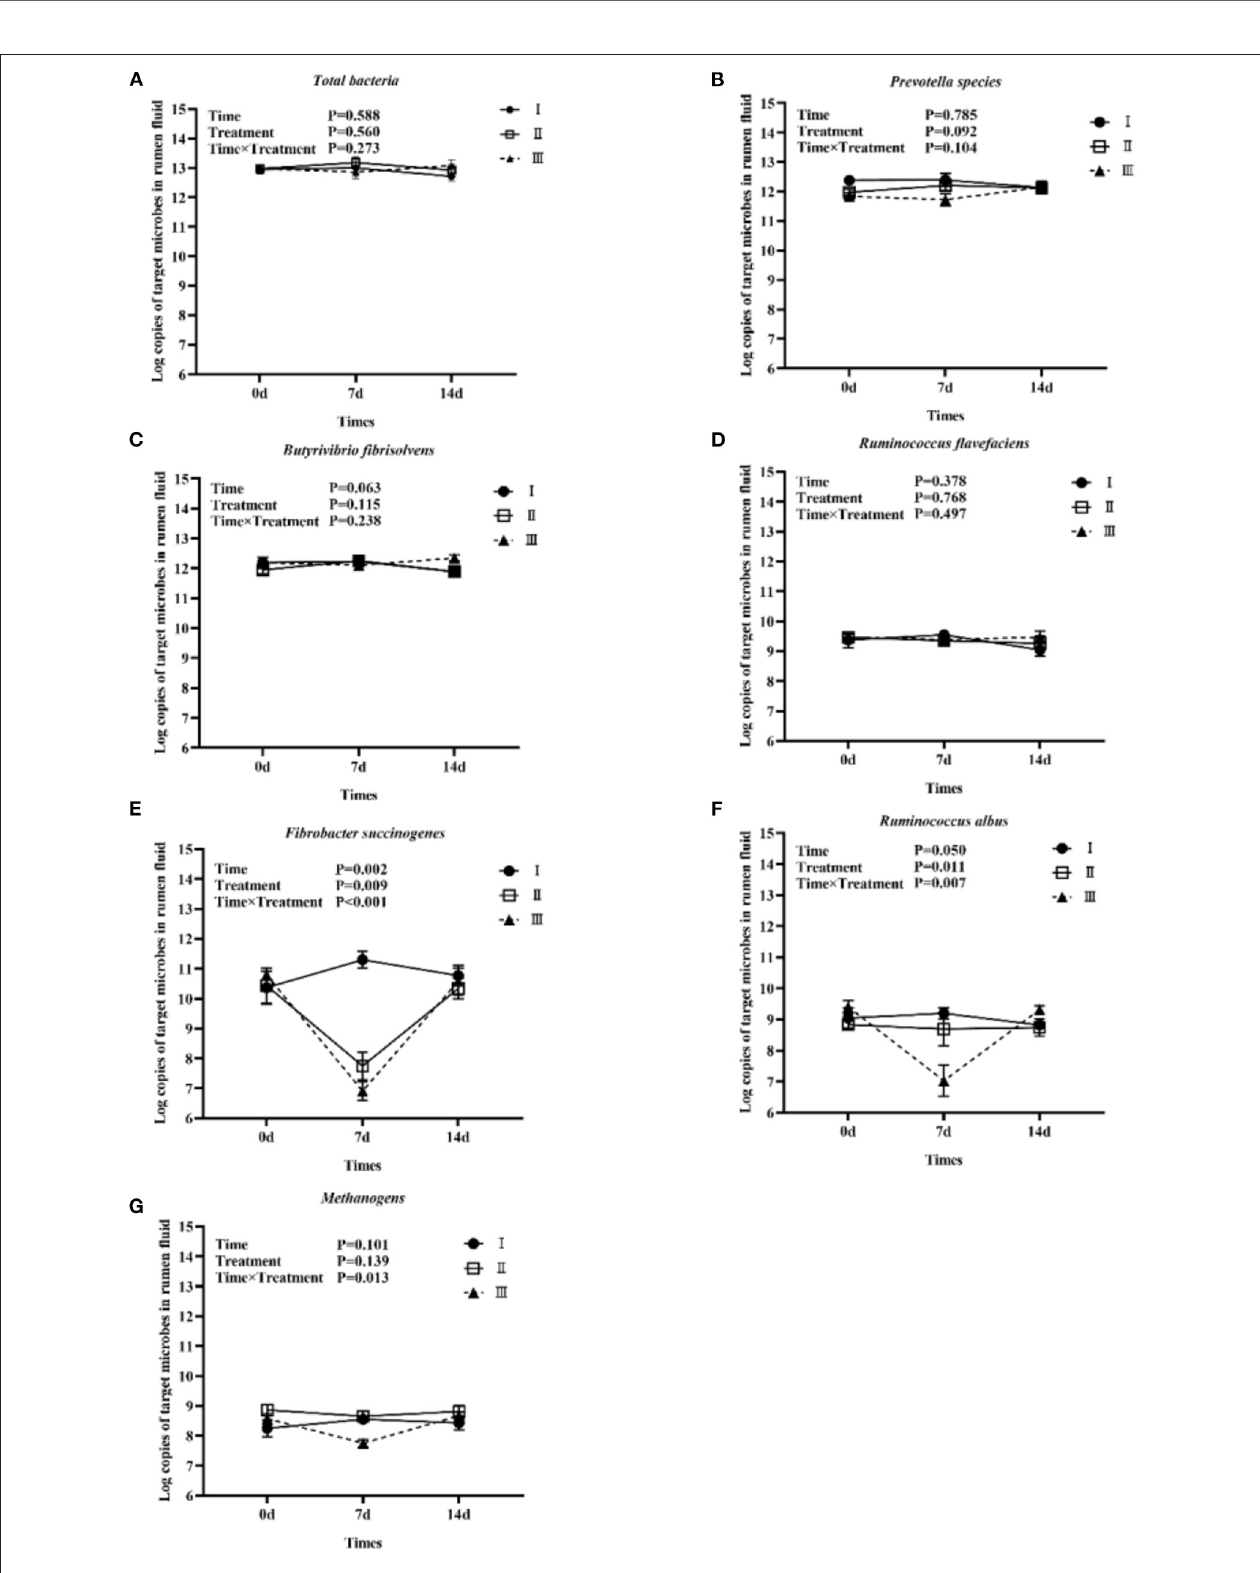
FIGURE 1 | Trends of eight target microorganisms during the experiment. (A–G) represent the log copy numbers of Total bacteria , Prevotella species , B. fibrisolvens , R. flavefaciens , F. succinogenes , R. albus , and Methanogens during the 14-day trial, respectively. I was the blank control group; II was chlortetracycline rumen-protected granules treatment; III was chlortetracycline premix